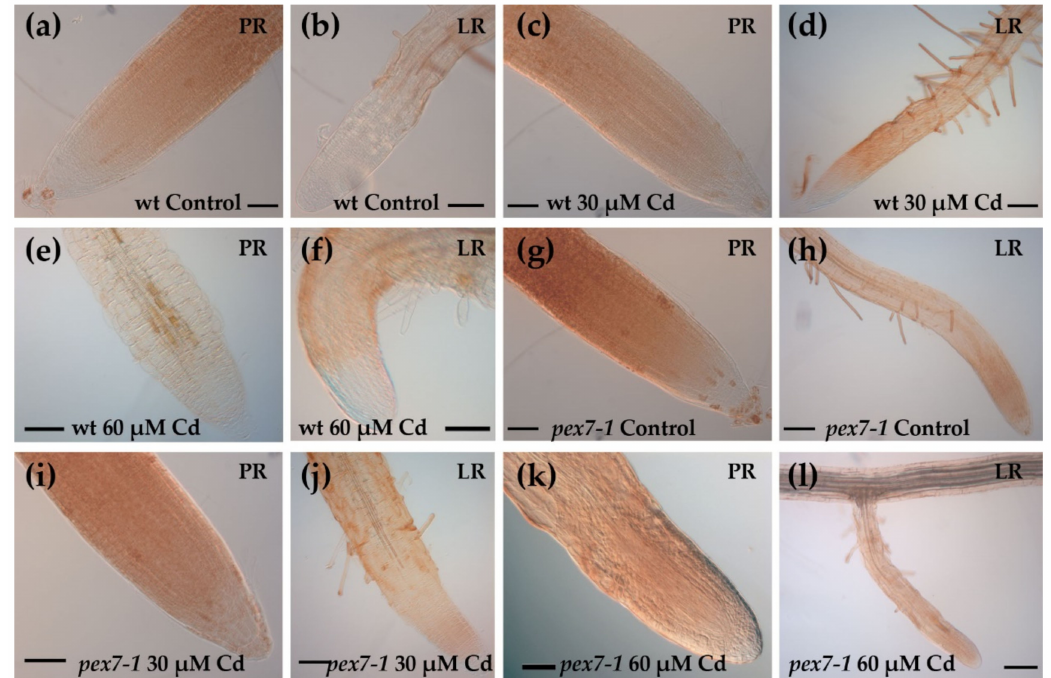
Figure 9. DAB histochemical analysis showing H 2 O 2 staining in the primary (PR) and lateral (LR) roots of the wt ( a – f ) and pex7-1 ( g – l ) seedlings grown in the absence (( a , b , g , h ), Control) or in the presence of 30 µ M CdSO 4 (30 µ M Cd) ( c , d , i , j ) or 60 µ M CdSO 4 (60 µ M Cd) ( e , f , k , l ). Images came from the three biological replicates. Bars = 100 µ m ( d – f , h , j – l ), 50 µ m ( a – c , g , i ). n =